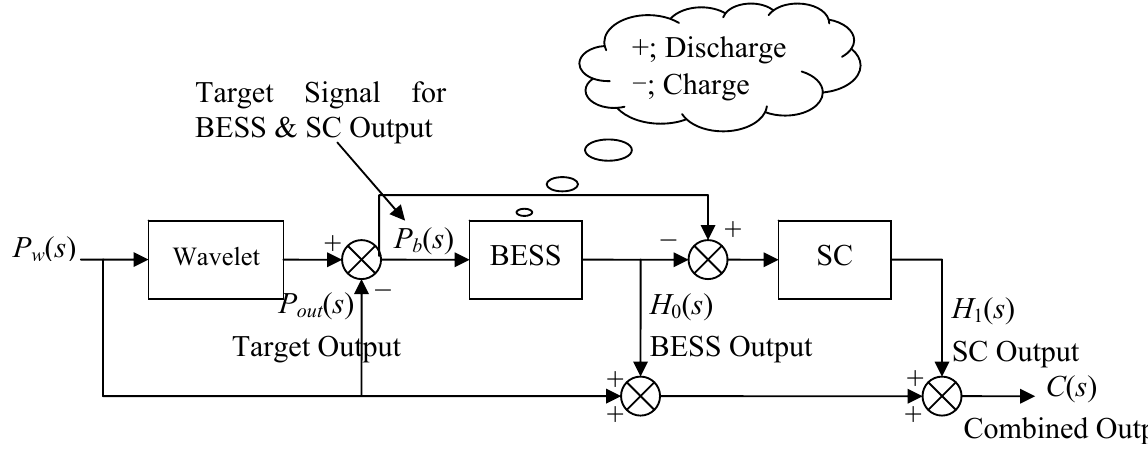
Figure 11. The structure diagram of a hybrid energy storage system with BESS and SC.